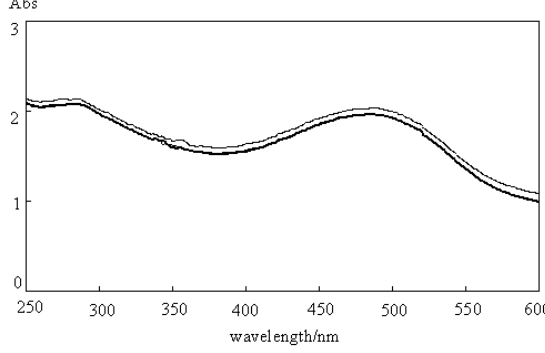
Figure 6. PMMA-DR1 absorption spectra. Conditions as in Fig. 4. Figure 7. PMMA-DR1-Mn